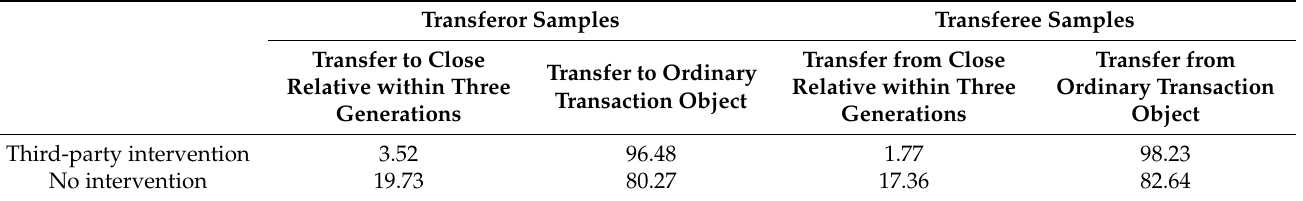
Table 3. Descriptive evidence of the impact of third-party intervention on relationship governance. Unit: %.